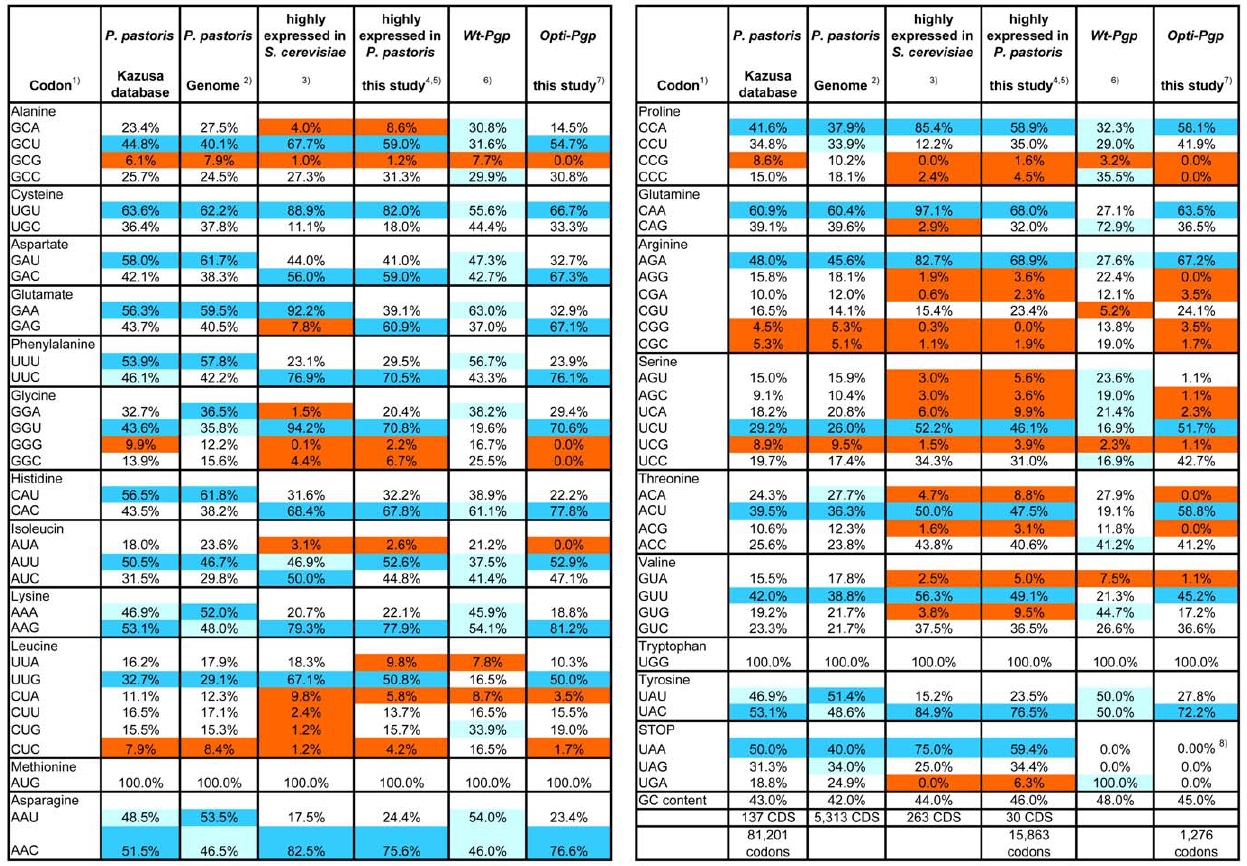
Figure 1. Comparison of codon usage. 1) Codons with low frequency ( , 10%) are highlighted in red. The most preferred codon for each amino acid is highlighted in dark blue. Most frequent codons (and second most frequent, if within 10% of the first) in WT-Pgp are highlighted in light blue. 2) From [23]. Five codons occur at low frequencies in the Kazusa and Genome databases, which do not discriminate between poorly and high expressed genes, e.g. the codons for Ala (GCG), Leu (CUC), Arg (CGG and CGC) and Ser (UGG). Some preferred codons differ between the Kazusa and the Pichia genome databases, namely the codons for Gly, Lys and Asn; this is likely due to the limited number of 137 CDS’s represented in the former. 3) From [15]. 4) The codon usage analysis was updated March 2011 to include the 30 most highly expressed genes in P. pastoris (see Table S1) based on proteome analysis [26,27,28]. Incidentally, all 30 genes are also among the 100 most highly transcribed genes seen in microarrays (Mattanovich, unpublished observations). 5) In highly expressed genes, an additional 18 codons occur at low frequencies, e.g. the codons for Ala (GCA), Gly (GGG and GGC), Ile (AUA), Leu (CUA, CUC and UUA), Pro CCG and CCC), Arg (AGG and CGA), Ser (AGU, AGC and UCA), Thr (ACA and ACG) and Val (GUA and GUG). Comparison of the preferred codon between highly expressed Pichia genes and the Kazusa/genome databases revealed an inverted preference for the Asp codon AAC over AAU, CAC over CAU for His and UUC over UUU for Phe. There was also a strong preference for the Lys codon AAG over AAA, AAC over AAU for Asn, and UAC over UAU for Tyr among highly expressed Pichia genes. Notably, the codon choice for Glu differed between highly expressed genes of the two yeasts with S. cerevisiae showing a clear preference for GAA (92%) whereas P. pastoris has a more balanced distribution of 61:39% between GAA and GAG. 6) The native Pgp revealed extensive codon bias, with pronounced over-representation of codons occurring at low frequency among highly expressed Pichia genes; viz. codons used for Ala (GCG), Gly (GGG, and GGC), Ile (AUA), Leu (CUA and CUC), Pro (CCC and CCG), Arg (AGG, CGA, CGG and CGC), Ser (AGC, AGU, UCA and UCG), Thr (ACG), and Val (GUA). The native gene also under- represented the Pichia higher frequency codons including the preferred codons (compare dark and light blue in columns 4 and 5). For example, the three codons for Ala (GCA, GCU and GCC) are used at about equal frequencies (30–32%) in WT-Pgp whereas highly expressed Pichia genes show a clear preference for GCU (59%) over GCC (31%) and GCA (9%). 7) For gene optimization all low-frequency codons ( , 8%) were set to zero and the distribution of frequencies adjusted to those of highly expressed Pichia genes. In some cases, desirable restriction enzyme sites required the presence of a low-frequency codon. 8) The C-terminal His 6 -tag and STOP codons were provided by the pLIC-H 6 vector (Fig. S2) and were CAT CAT CAT CAT CAT CAT